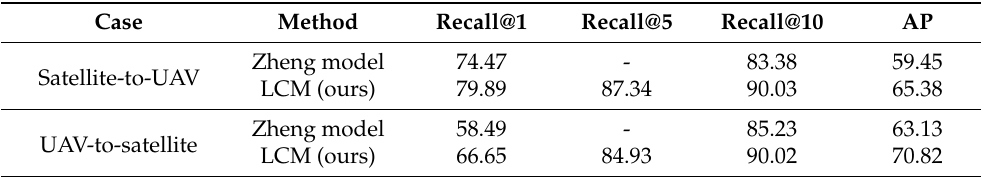
Table 2. Comparison of matching accuracy (%) between the location classification method (LCM) baseline model and Zheng model (a single image is used as the query).